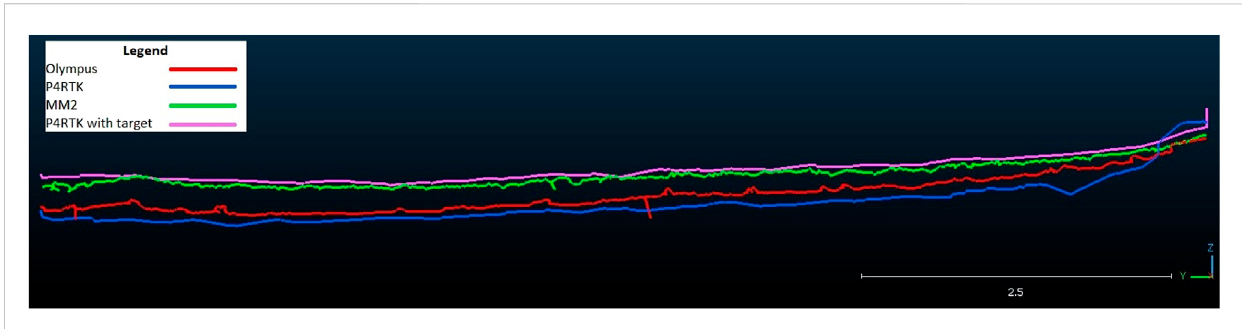
FIGURE 5 Cross sections – Differences between four topo-bathymetrical pro fi les (one for each photogrammetric reconstruction generated for AoI2). Note: scale bar unit is set to